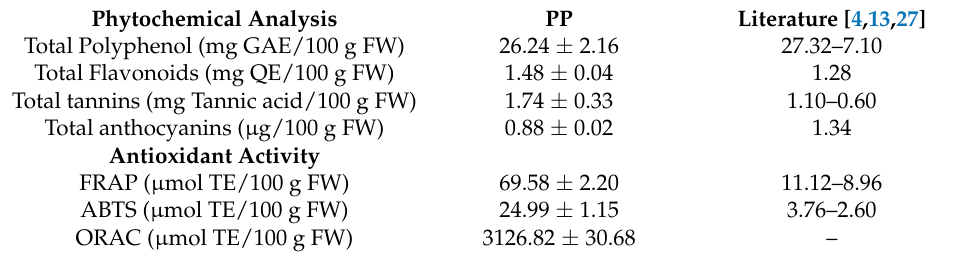
Table 3. Phytochemical analysis and antioxidant activity of P. peruviana . Phytochemical Analysis